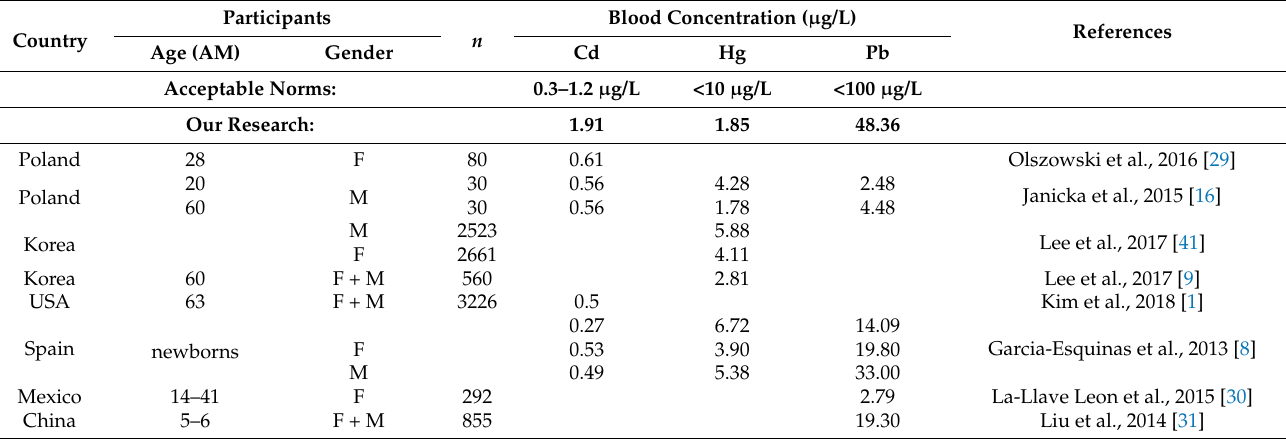
Table 5. Concentrations of blood Cd, Hg, and Pb (in µ g/L) in other group of patients from Poland and other countries.